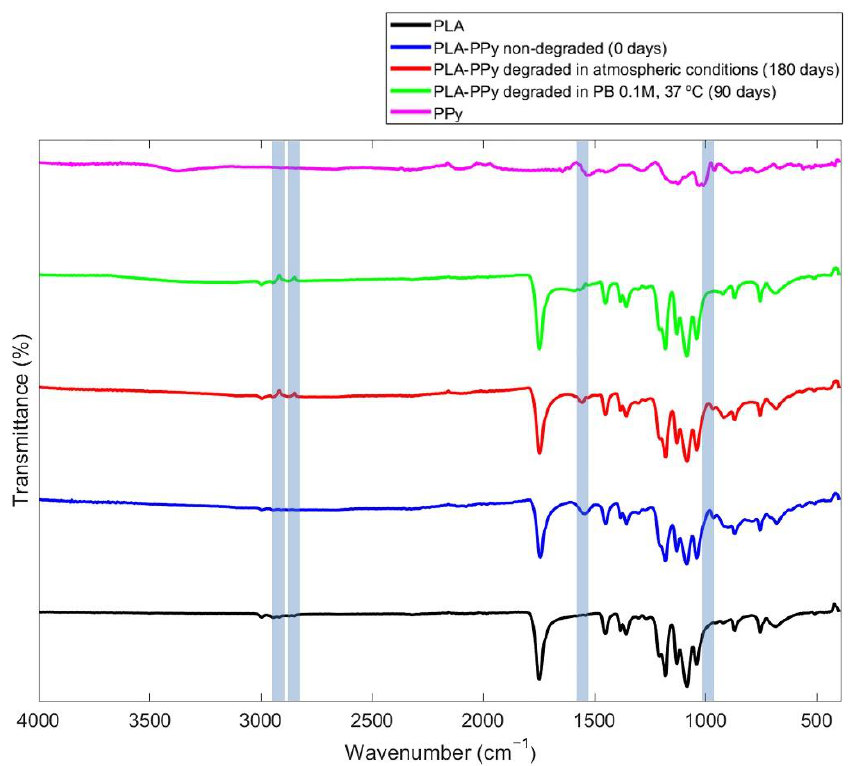
Figure 2. FTIR spectra of PLA microfibers (PLA), non-degraded PLA-PPy microfibers, PLA-PPy microfibers degraded in atmospheric conditions for 180 days, PLA-PPy microfibers degraded in PB 0.1M at 37 °C for 90 days and pure PPy (PPy). The vertical shaded areas are highlighting the differential characteristic peaks that are studied.